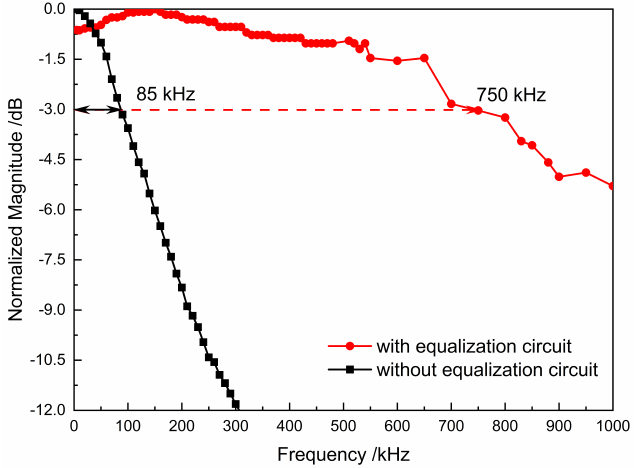
Figure 7. Frequency response of the zero-power-consumption VLC system with/without equaliza- tion